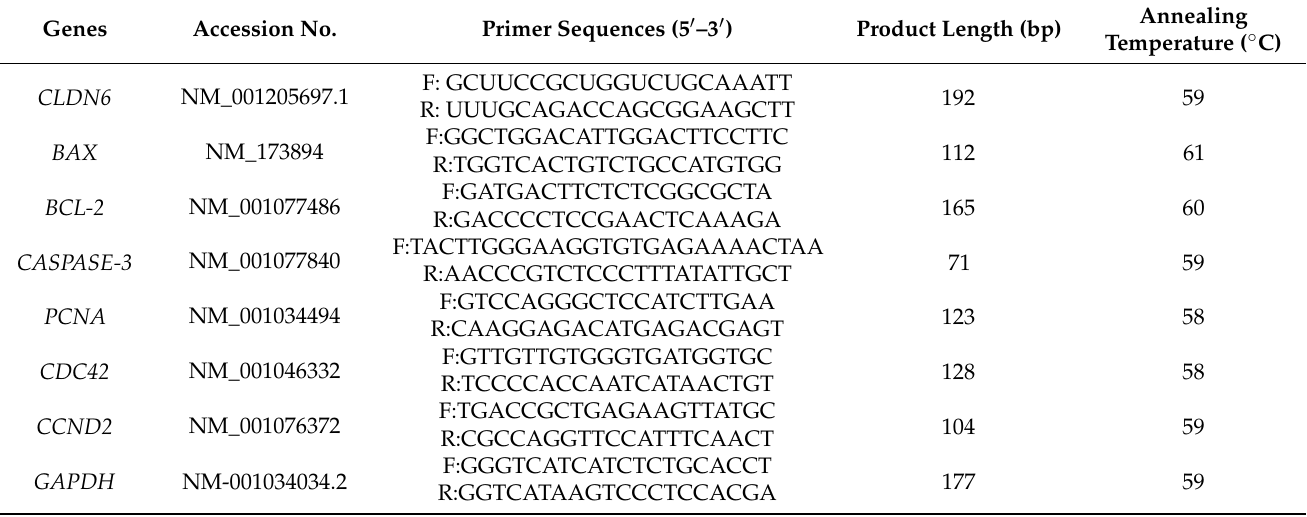
Table 2. Primer sequences for